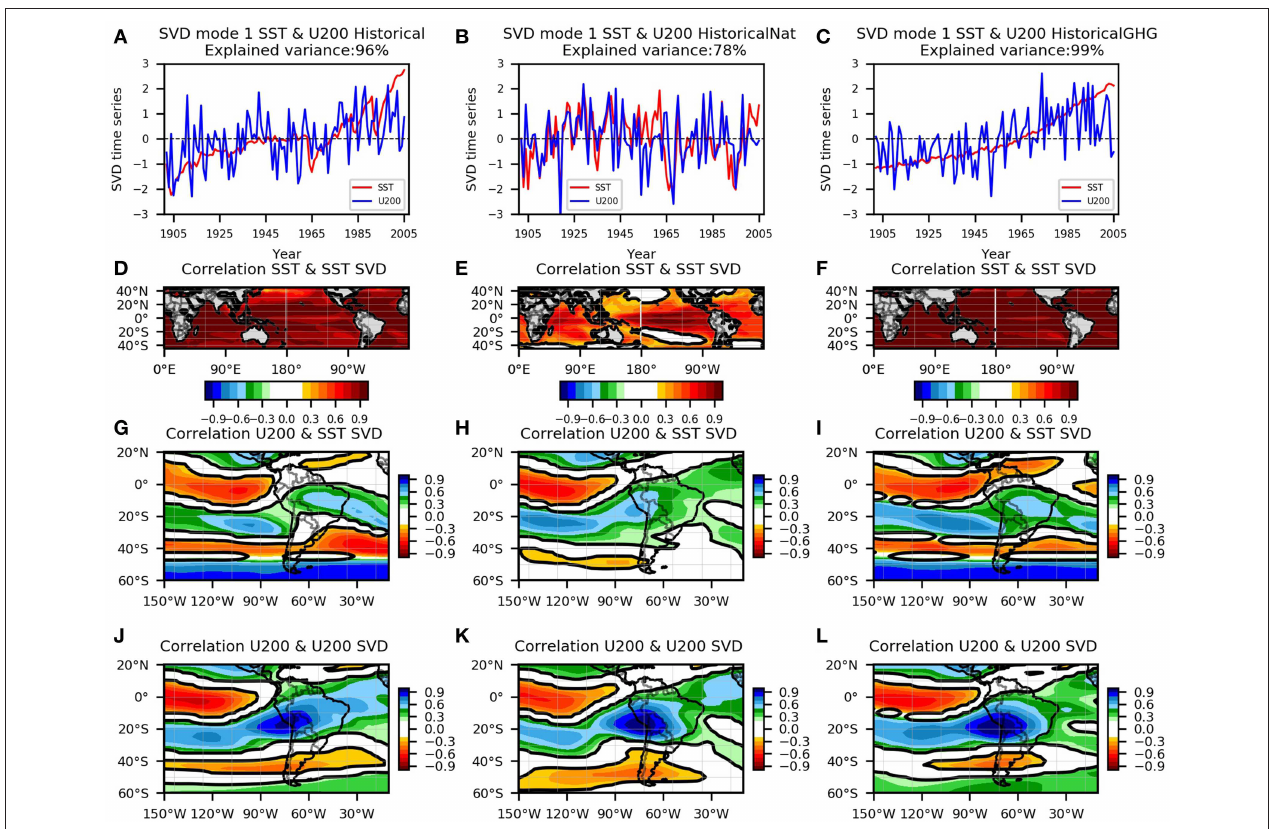
FIGURE 5 | (A) SVD time series of SST (blue) and U200 anomalies (red) over Altiplano for Historical simulations multi-model ensemble for the period 1902–2005. (D) Homogeneous correlation map between the SVD time series of SST and SST anomalies. (G) Heterogeneous correlation map between the SVD time series of SST and U200 anomalies. (J) Homogeneous correlation map between the SVD time series of U200 and U200 anomalies. (B,E,H,K) same as (A,D,G,J) , but for HistoricalNat simulations. (C,F,I,L) same as (A,D,G,J) , but in HistoricalGHG simulations.